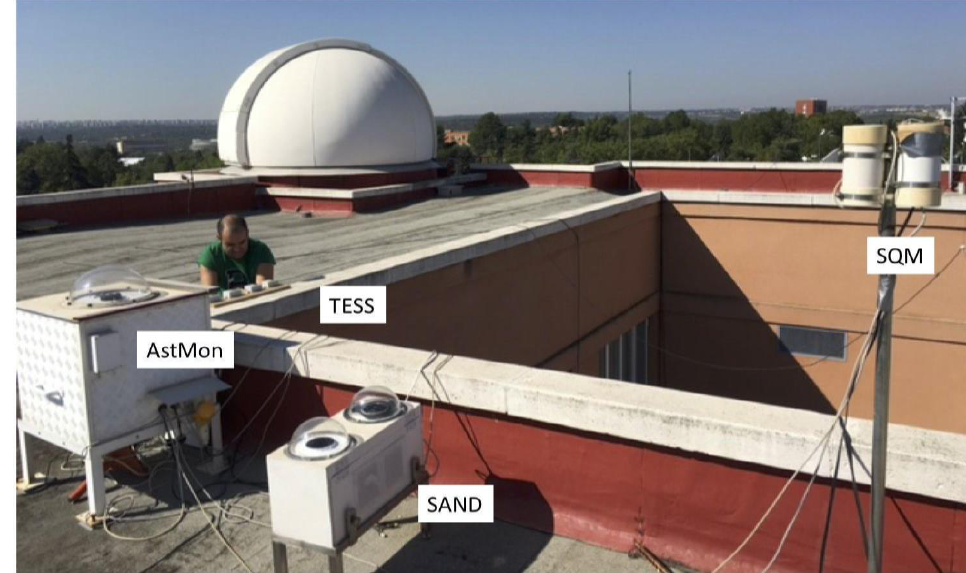
Figure 3. Universidad Complutense de Madrid (UCM) Observatory with labeled devices to monitor light pollution near the astronomical observatory domes.